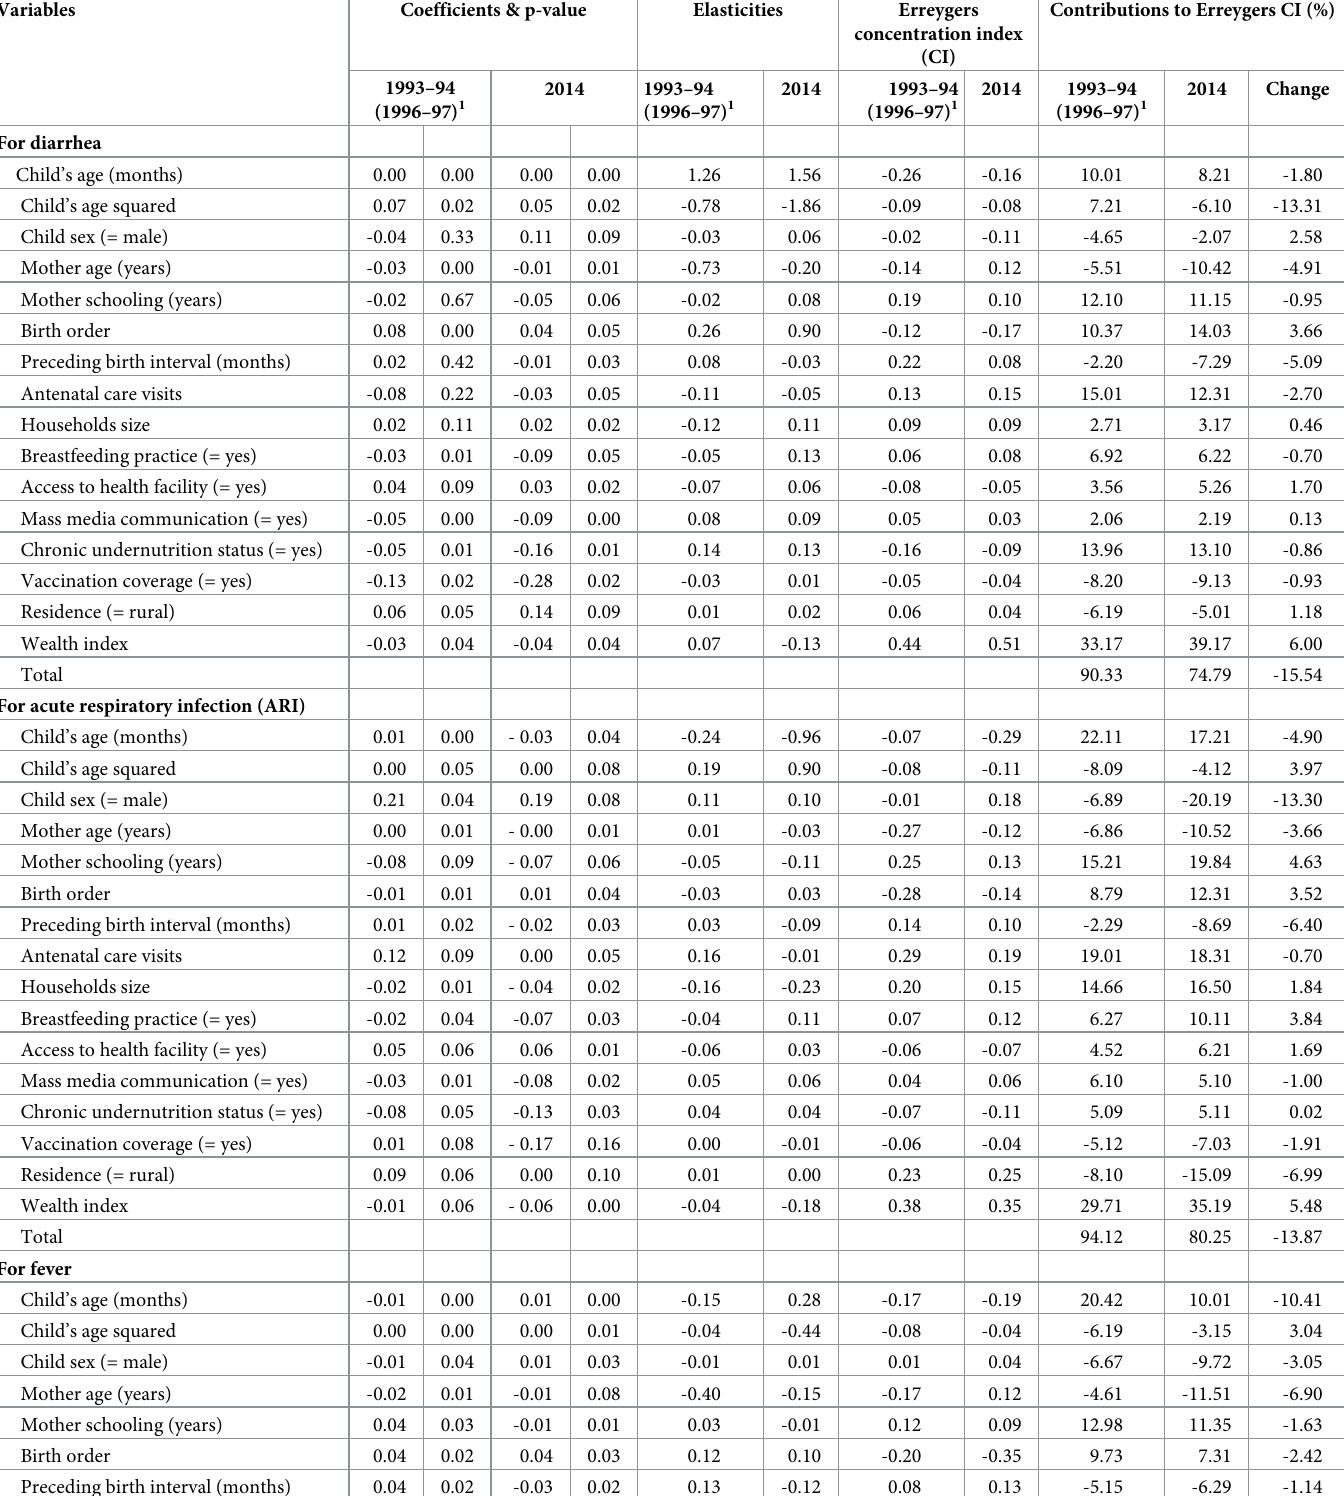
Table 1. Inequality decomposition of the Erreygers’s concentration index for childhood morbidity,